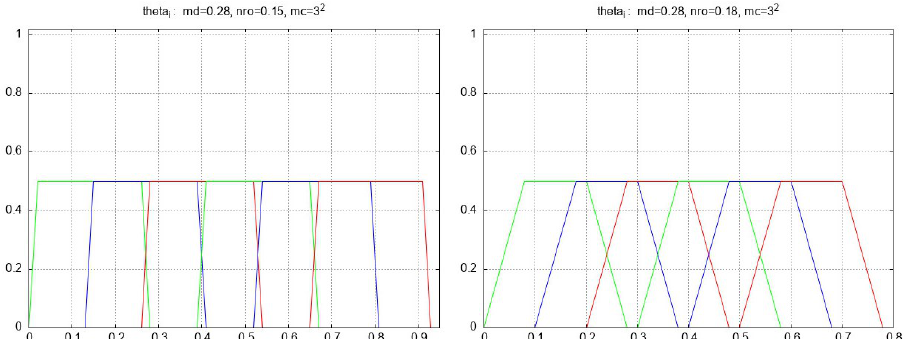
Figure 5. Sections in the direction of a coordinate axis passing through the center of the functions of a unity partition: δ = 0.15 ( left ) and δ = 0.18 ( right